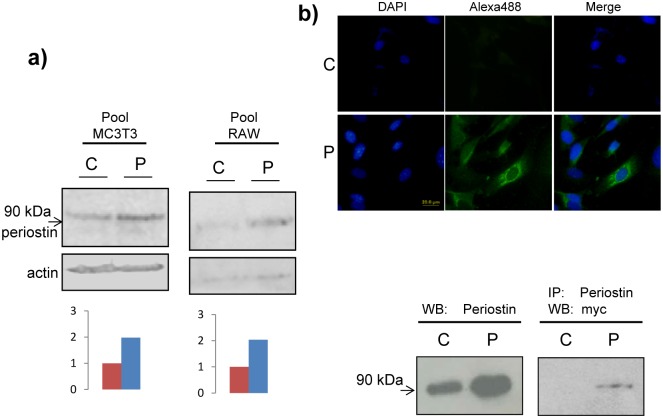
Selection of stable MC3T3-E1 and RAW 264.7 transfectants.a) Western blot analysis of MC3T3-E1 and RAW 264.7 producing exogenous periostin. Control, cells transfected with an empty vector. Top, detection with an anti-periostin antibody. An anti-Actin antibody was used as a loading control. Bottom, representation of normalized expression using values from Image J densitometry of western-blots. C, control cells. P, periostin overexpressing cells. b) Recombinant periostin is secreted to the cell medium. Top, Cellular inmunolocalization of periostin in MC3T3-E1 transfectants; cells using a specific anti-myc primary antibody and an Alexa-488-conjugated secondary antibody (green). DAPI staining was used to detect nuclei (blue). Bottom, recombinant periostin is detected either with anti-periostin or in an anti-periostin inmunoprecipitate with an anti-myc antibody by western-blot in MC3T3-E1 cells conditioned medium. C and P indicate conditioned medium of control cells transfected with an empty vector and with a vector containing the full-length cDNA for periostin tagged with a c-myc epitope respectively.